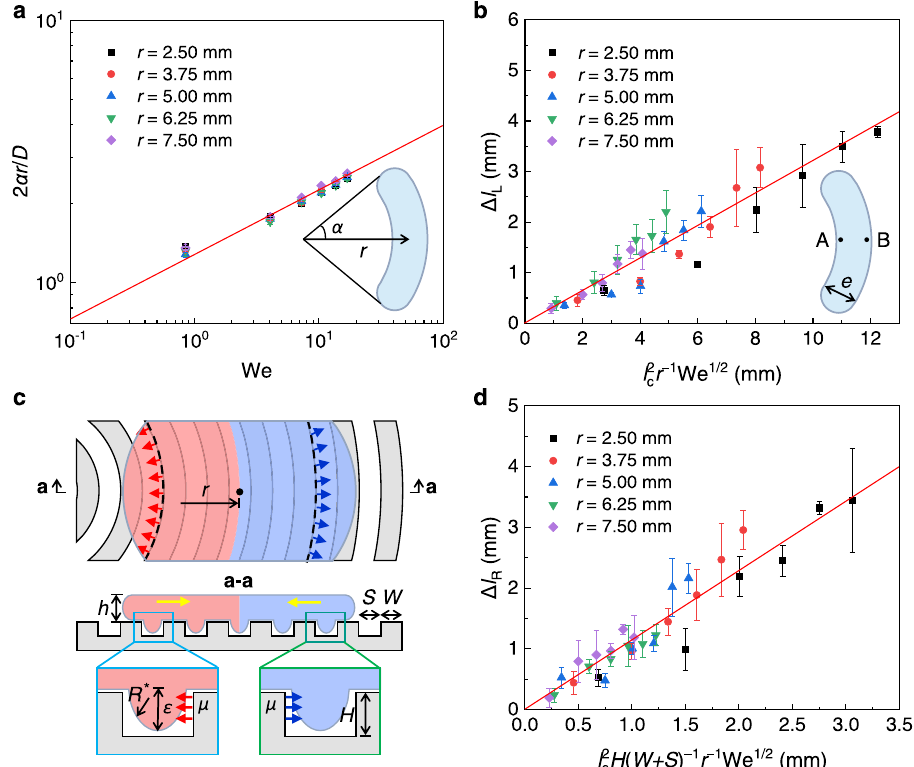
Fig. 4 Mechanism for the lateral transport of drops in the transition boiling (a and b) and fi lm boiling (c and d). a Relationships between 2 α r / D and We. b The lateral displacement Δ l L as a function of We and the initial off-center distance r . Here, R = 1.18 mm, and the red solid lines in a , b are respectively the best fi ts of Eqs. 1 and 3 to the experimental data. c The top panel sketching the morphology of the drop during recoiling from the top view. The red and blue arrows represent the forces that the grooves exert on the liquid. The bottom panel sketching the wetting state of the sections a-a. The left and right parts of the drop are marked by the light red and light blue shadows, respectively. d The lateral displacement Δ l R as a function of We and r . The solid line is the best fi t of Eq. 5. The error bars of the data in a , b , d denote the standard deviation of three measurements. Source data are provided as a Source Data fi